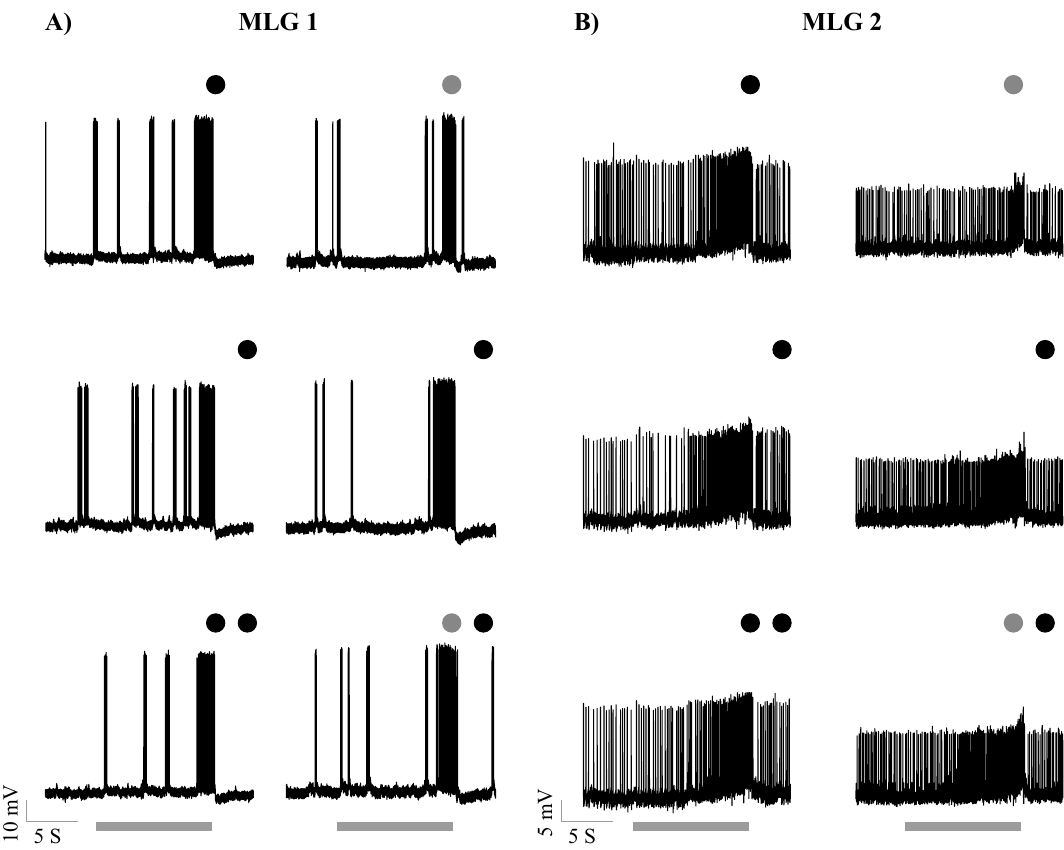
Figure 5. Example responses of ( A ) MLG1 and ( B ) MLG2 neurons to single and paired stimuli. Both neurons responded by gradually increasing their firing rate before the end of stimulation. The circles above the response traces show the type of stimulus used in each recording. A single circle represents a single stimulus and double circles represent paired stimuli. The colour of the circles indicated stimulus contrast (Webber contrast): − 100% (black) and − 40% (grey). The grey bar below the response trace shows the duration of